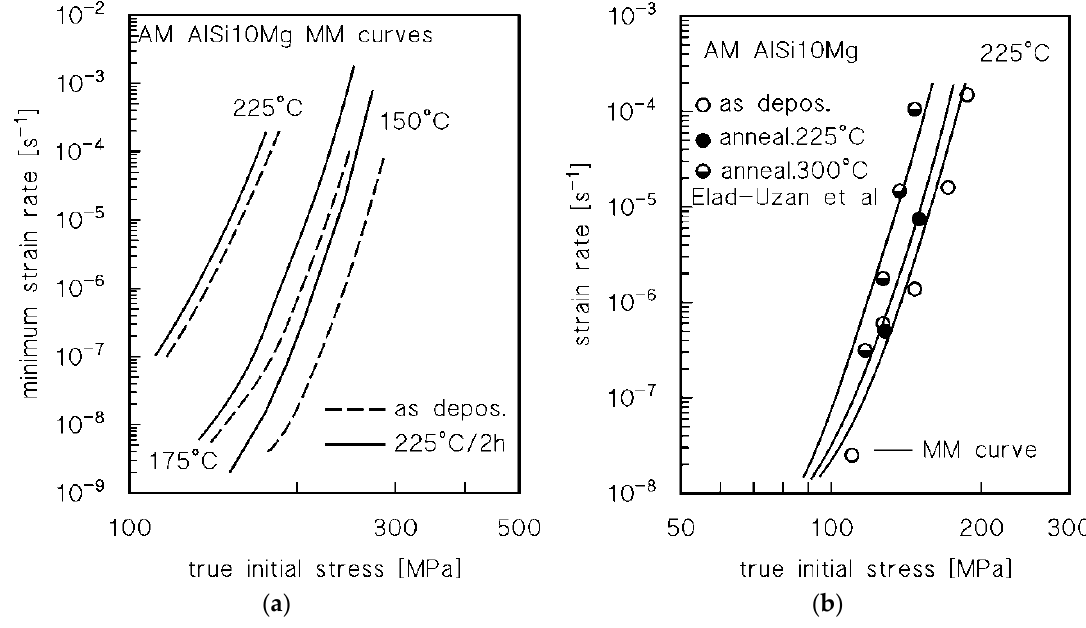
Figure 8. ( a ) Model curves calculated for the as-deposited and the heat-treated (225 °C for 2 h) alloy; ( b ) minimum creep rate obtained at 225 °C for the as-deposited alloy [14] and for the alloy annealed for 2 h at 225 °C (this study) and at 300 °C [22]; ( b ) also includes the model curves calculated by combining the MM and the equations reported in Appendixes A and B.